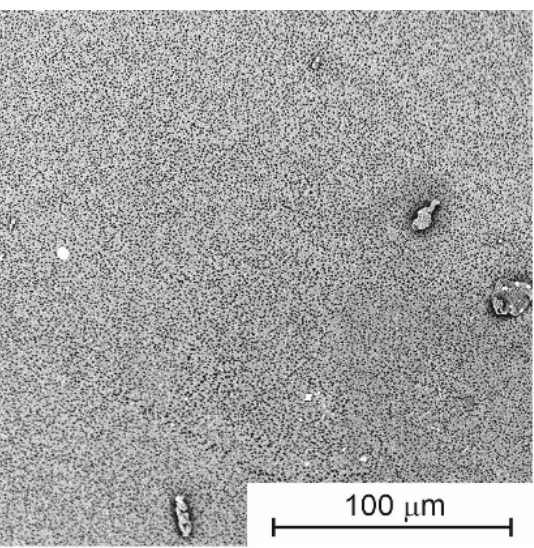
Figure 2 . SEM image of the inside of a cylindrical membrane. Figure 2. SEM image of the inside of a cylindrical membrane. However, the modifications carried out resulted in changes observable on SEM images, occurring on the outer side of the cylindrical membrane. Figure 3 presents images showing the exterior of the modified membrane for different